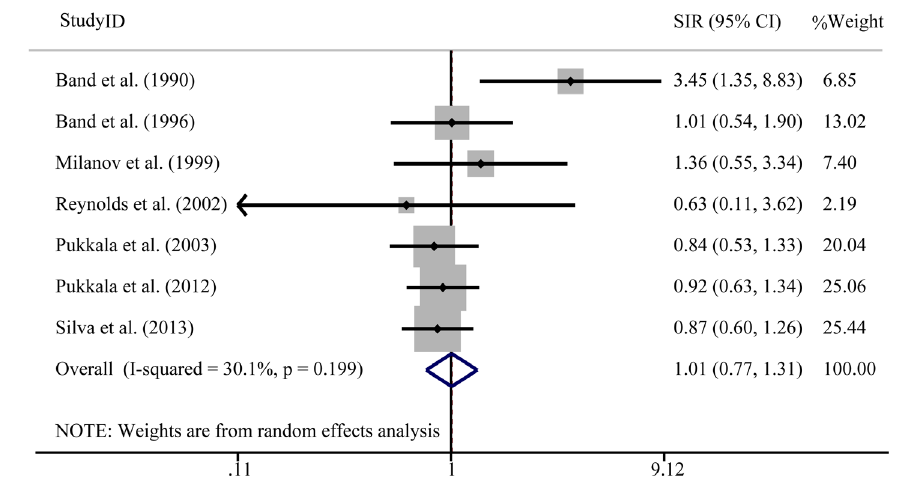
Figure 2. Meta-analysis of Observational Studies on BNSC Incidence Among Aircrew Based on Random-Effect Models.